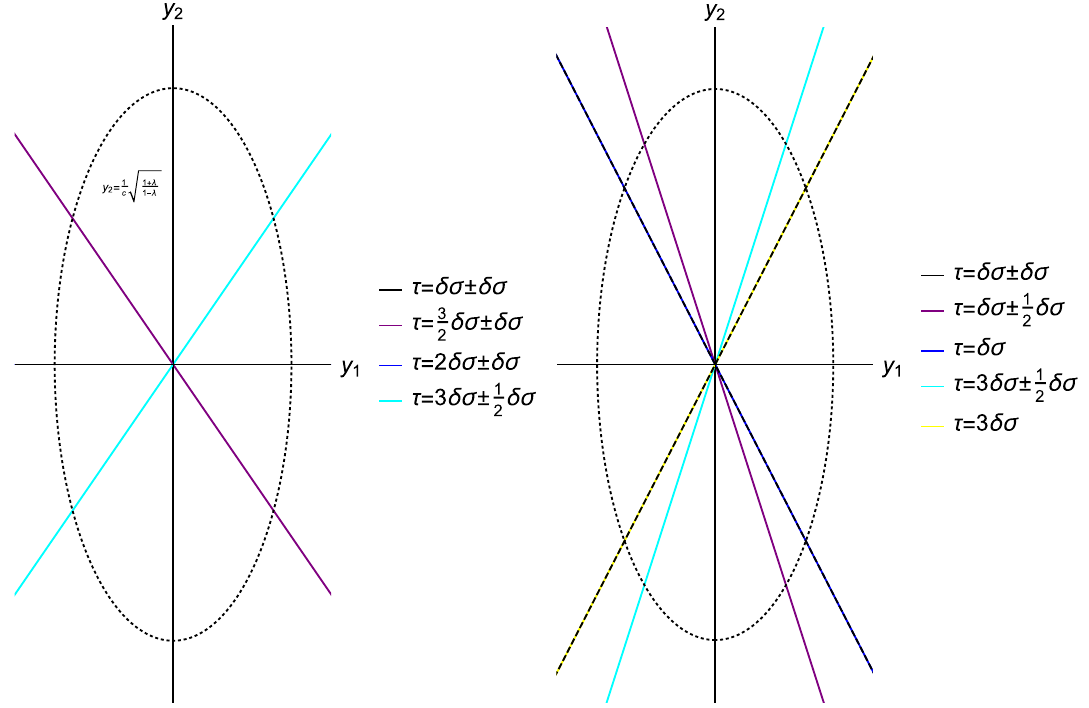
Fig. 4 Indicative translationally invariant solutions of the SL ( 2 , R )/ U ( 1 ) A model. The left panel corresponds to a rotating solution, while the right one to an oscillating solution. Notice, again, that as λ > 0 the angle ψ of the oscillating solution “oscillates” around π/ 2. The equation of dotted ellipses is